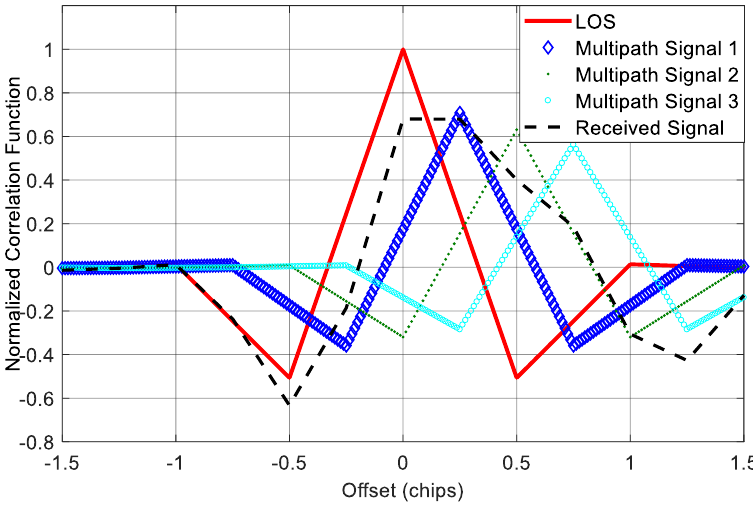
Figure 12. Correlation functions in the presence of three multipath components.